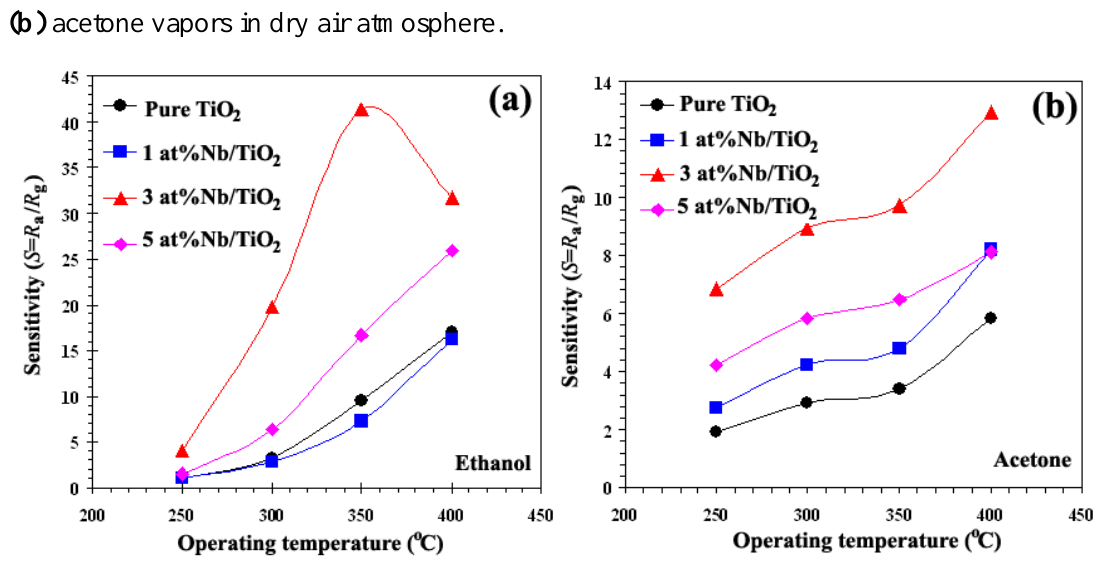
Figure 4. Change in resistance of sensors under exposure to reducing (a) ethanol and (b) acetone gases during backward cycle with various concentration of ethanol (50–1,000 ppm) and acetone (25–400 ppm) in dry air at 400